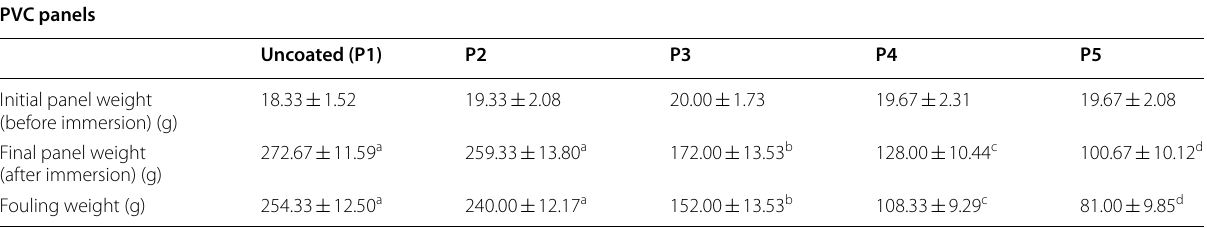
Data are shown as the mean SD with different letters in the same row are significantly different at p < ±